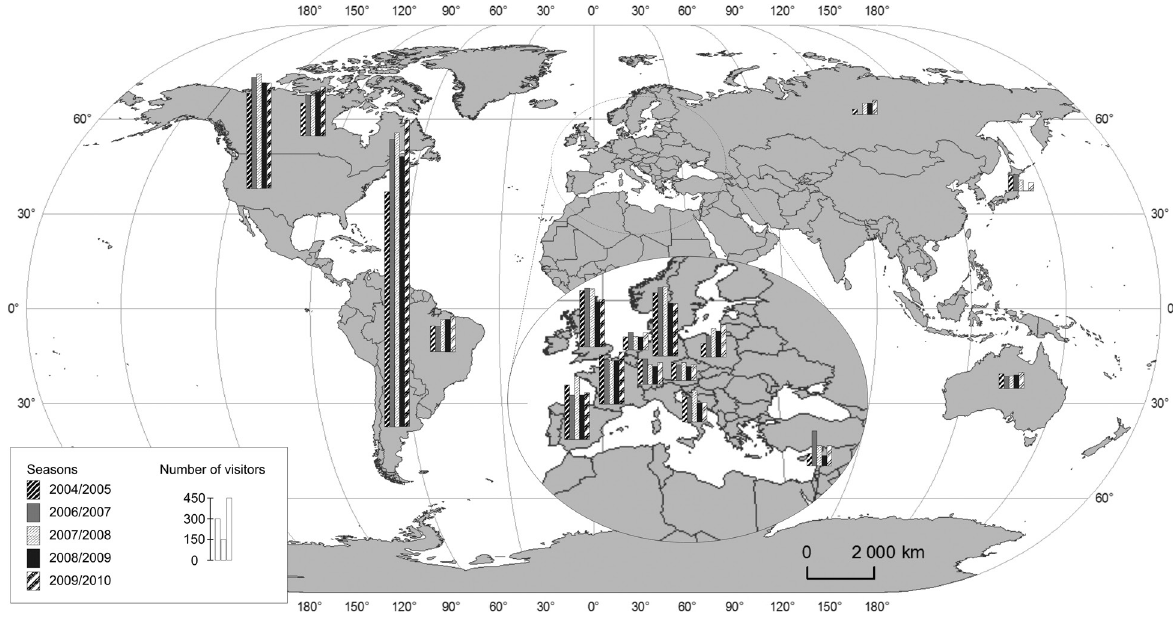
Fig. 5. Number of tourists visiting Aconcagua massif according to countries and tourist